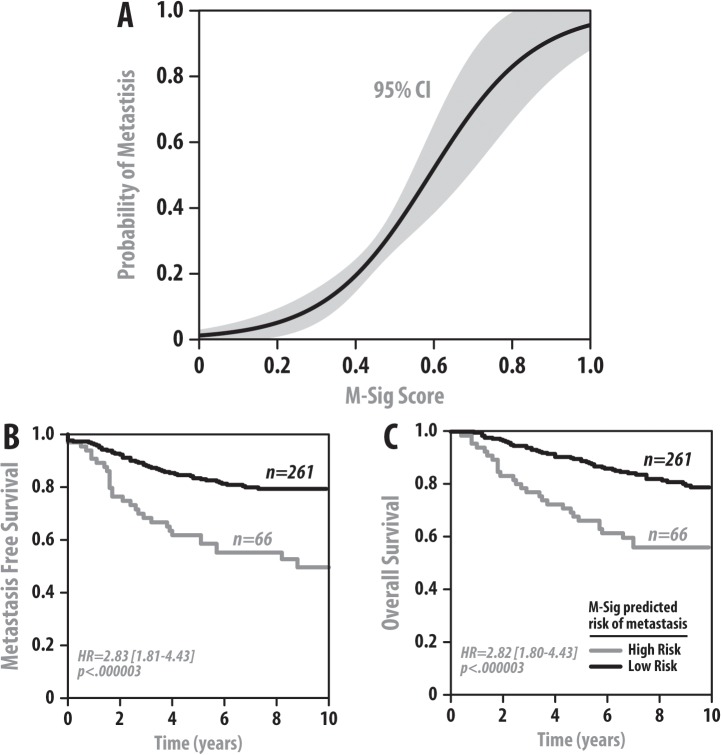
M-Sig Training.(A) M-Sig logistic regression curve demonstrates the sigmoidal relationship between the cross validated OOB M-Sig score (0–1 score representing the M-Sig prediction of metastasis risk, x-axis) and the actual probability of metastasis in the training cohort (y-axis). 95% confidence intervals are also displayed and are fitted tightly around the curve, with an inflection point around 0.5. Kaplan Meier curves depicting metastasis-free survival estimates (B) and overall survival estimates over time (C) demonstrate a significant difference between the groups defined as high versus low risk by M-Sig score. M-Sig was able to significantly distinguish between high vs. low risk for metastasis and OS. Hazard ratios (HR) are shown with 95% confidence intervals.